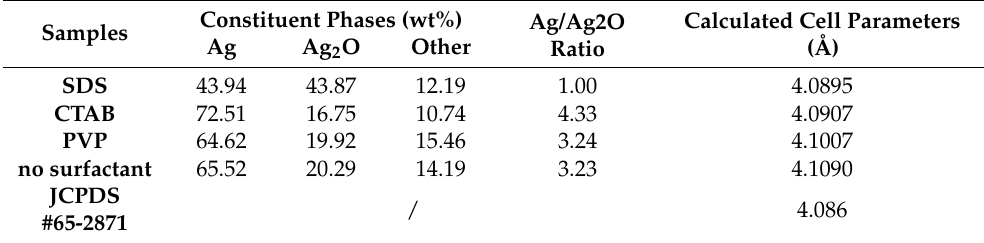
Figure 1. XRD patterns of Ag nanoparticles synthesised using pulsed plasma in aqueous solution in the presence of different surfactant materials. The individual peaks corresponding to different crystal planes from the Ag and Ag 2 O phases are marked in the figure. Table 1. Calculated content ratio of the constituent phases of the samples prepared using different kinds of surfactants and their cell parameters.